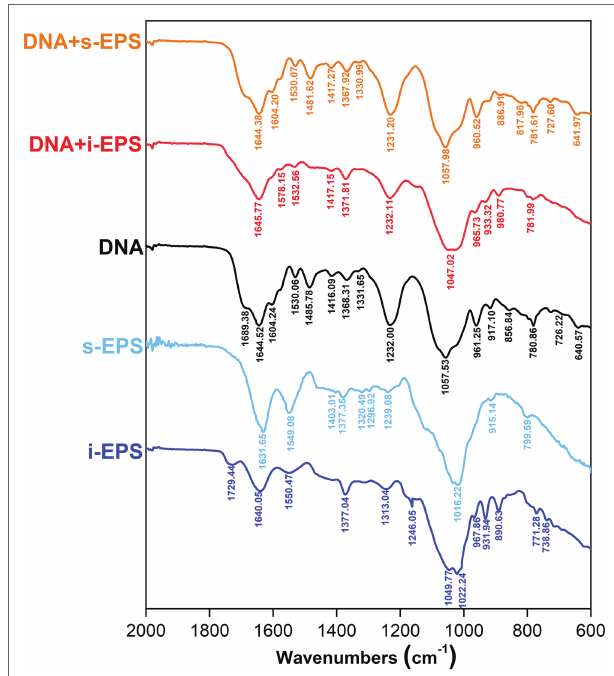
FIGURE 6 | Fourier transform infrared (FTIR) spectra of DNA, exopolysaccharides (EPS), and DNA-EPS complex. The spectrum was collected in the range of 2,000–600 cm − 1 . i-EPS, insoluble EPS; s-EPS, soluble EPS; DNA + i-EPS, complex of DNA and insoluble EPS; DNA + s-EPS, complex of DNA and soluble EPS.